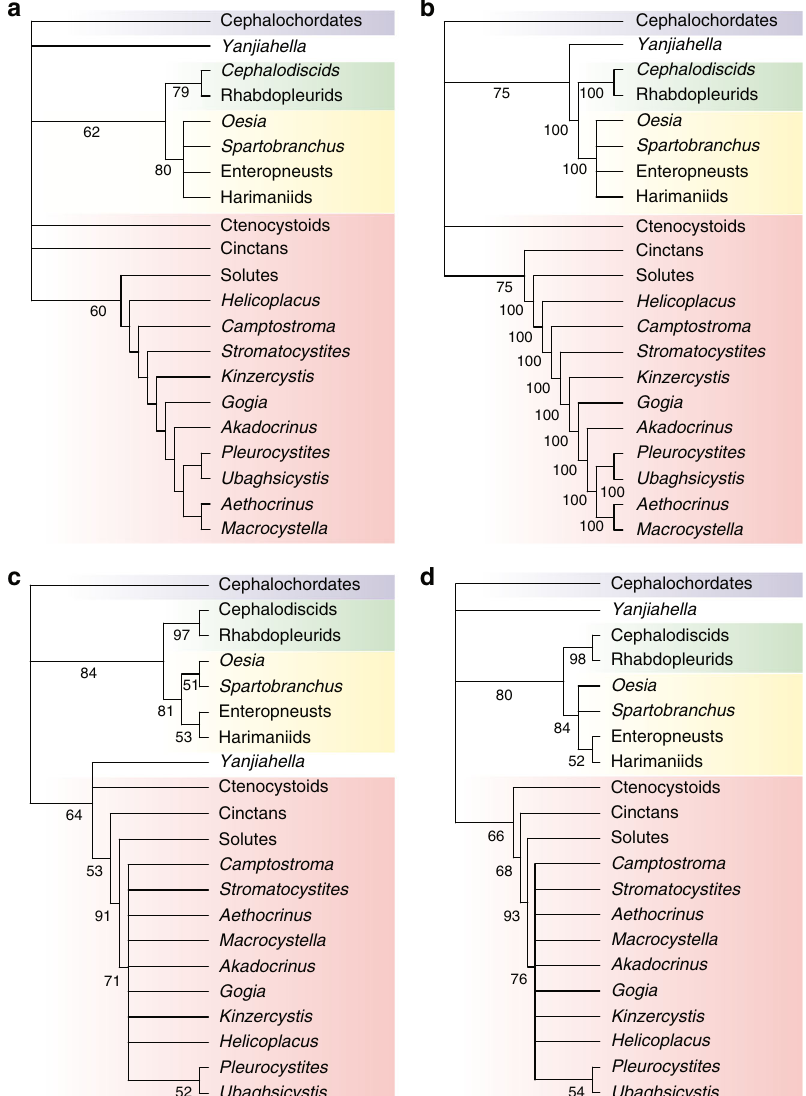
Fig. 2 Phylogenetic uncertainty in placement of Yanjiahella . a Strict consensus of twelve most parsimonious trees (MPTs) recovered via maximum parsimony analysis of the matrix in Topper et al. 3 (including parsimony uninformative characters: tree length = 70, CI = 0.657; excluding parsimony uninformative characters: tree length = 63, CI = 0.619), node values = bootstrap support via 1,000 replicates. b parsimony-based 50% majority rule tree, node values = clade frequencies across MPTs. c Bayesian 50% majority rule tree of the matrix in Topper et al. 3 , node values = posterior probability (%). d Bayesian 50% majority rule tree from a matrix in which Yanjiahella is re-scored as lacking stereom (character 16), node values = posterior probability Methods implicit enumeration with branch collapse settings off. Bayesian analyses were Character matrices . To quantify support for the phylogenetic placement of Yan- conducted in MrBayes 3.2.5 14 using Markov chain Monte-Carlo (MCMC). We jiahella , we re-analyzed the original matrix in the Supplemental Information of Topper et al. 3 using both maximum parsimony and Bayesian approaches. In con- trast to Topper et al. 3 (cf. fi g. 3 and Supplementary fi gs. 6, 7), we present results matching each method ’ s respective optimality criteria (e.g., minimum-length trees for parsimony analysis) only. We also conducted analyses with Yanjiahella re- scored as lacking stereom (i.e., changing character 16 from “ ? ” to “ 0 ” ). We note that 7 of the 42 characters (~17%) used by Topper et al. 3 are not parsimony informative. Phylogenetic analyses . Parsimony analyses were conducted in PAUP * 4.0a 12 using a heuristic search of 1,000 random addition sequence replicates with branch swapping via tree-bisection-reconnection. Branches with a minimum length of zero were collapsed. All characters were unordered and equally weighted. Bootstrap support was evaluated across 10,000 replicate matrices of the 35 parsimony- informative characters included in Topper et al. 3 . Summary statistics for the set of most parsimonious trees (MPTs) were calculated in PAUP * for both the total set of 42 characters and 35 parsimony-informative characters. To further compare our results with Topper et al. ’ s 3 fi gure 3, we also conducted analyses in TNT 13 using